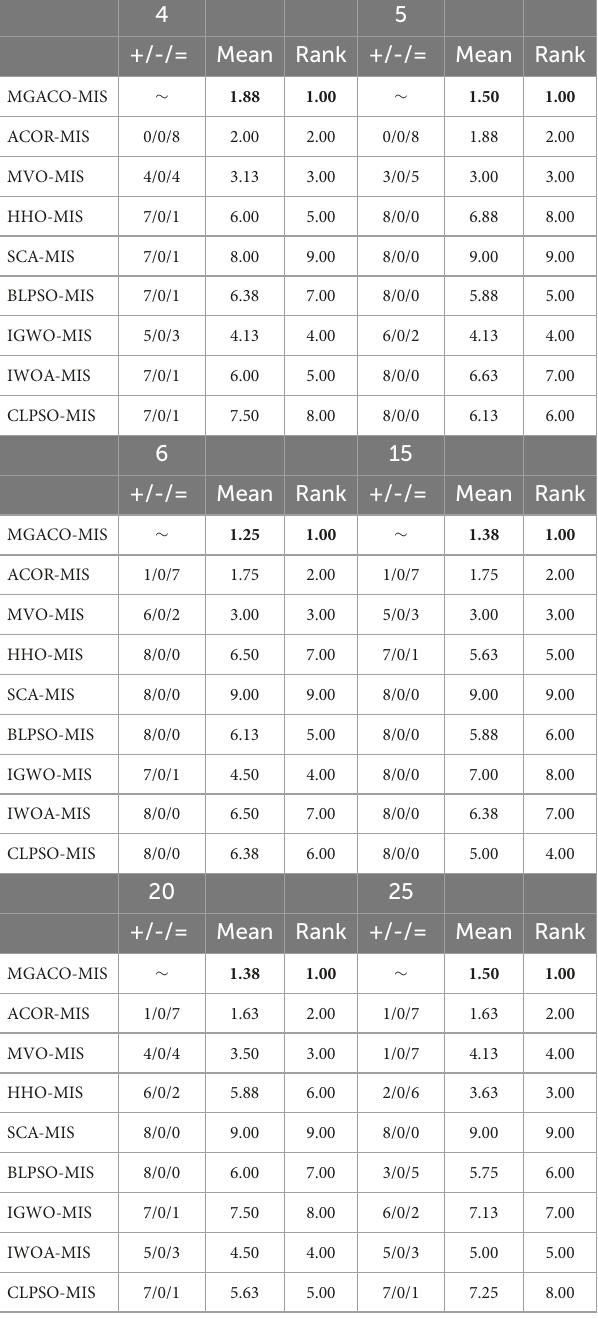
TABLE 4 The PSNR analysis results of MGACO and its peers at different threshold